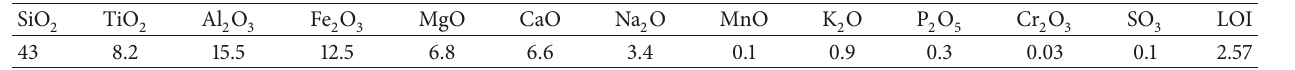
Table 1: Chemical composition of norite (wt.%).